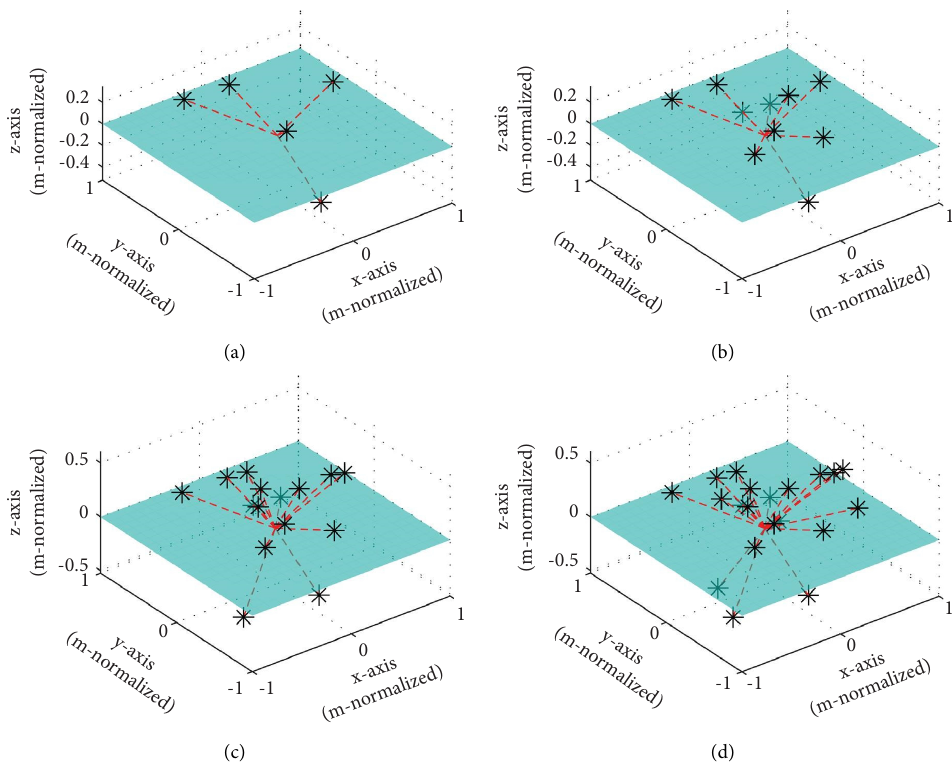
Figure 3: Collaborating nodes’ positions 3 dimension confguration with varying node count: (a) 5 nodes; (b) 10 nodes; (c) 15 nodes; (d) 20 nodes. Table 1: Collaborating nodes’ positions 3 dimension confguration with varying node count: 5 and 10 nodes. 10 nodes 5 nodes S. no. Norm. rad. dist.